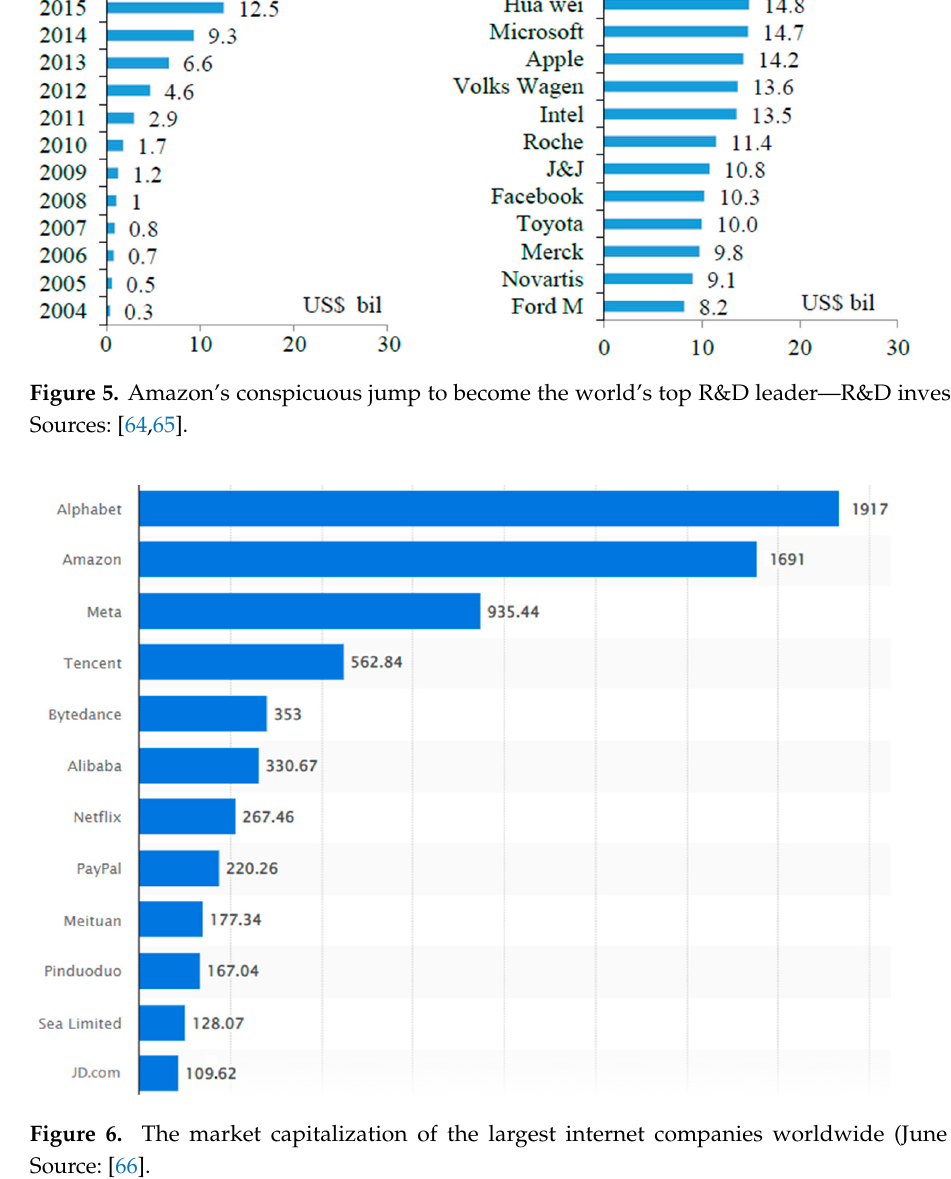
Figure 6. The market capitalization of the largest internet companies worldwide (June 2022). Source: [66].